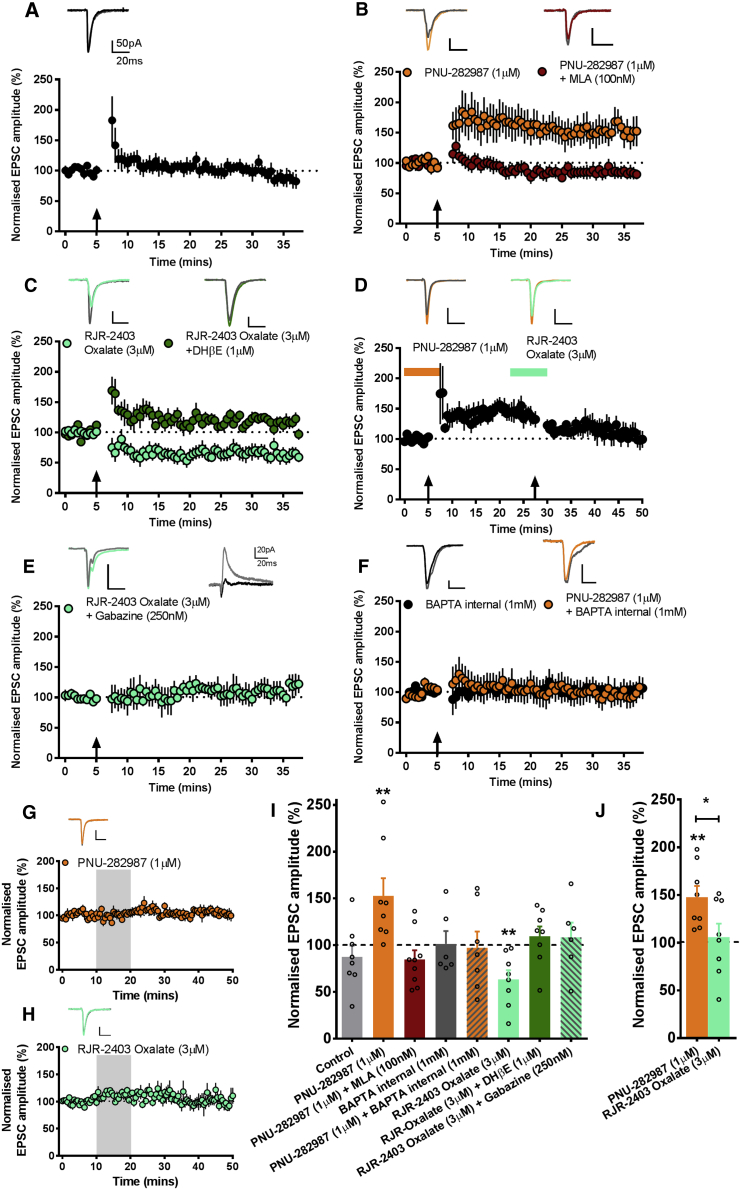
nAChRs Bidirectionally Modulate HPC-mPFC Plasticity(A) Transient potentiation following delivery of STDP, indicated by arrow (n = 8).(B) LTP induced by combined STDP and PNU-282987 (n = 8) was blocked in separate experiments by co-application of MLA (n = 9).(C) LTD induced by STDP with RJR-2403 oxalate (n = 8) was blocked by co-application of DHβE (n = 8).(D) Induction of PNU-282987 STDP LTP was reversed by RJR-2403 Oxalate STDP induced LTD (n = 8).(E and F) α4β2 nAChR LTD was blocked in the presence of gabazine (n = 6) (E), and α7 nAChR LTP was blocked by postsynaptic BAPTA (n = 7) (F).(G and H) Application of PNU-282987 (n = 6) (G) or RJR-2403 oxalate (n = 6) (H) in the absence of STDP did not induce plasticity. In all graphs, representative EPSCs are shown from baseline (gray traces) and the last 5 min (colored traces) of the experiment.(I and J) Summary of normalized EPSC amplitudes recorded in the final 5 min of each STDP experiment.Data are presented as normalized mean ± SEM (∗p < 0.05, ∗∗p < 0.01; paired t test in I or repeated-measures ANOVA with Bonferroni post hoc in J).